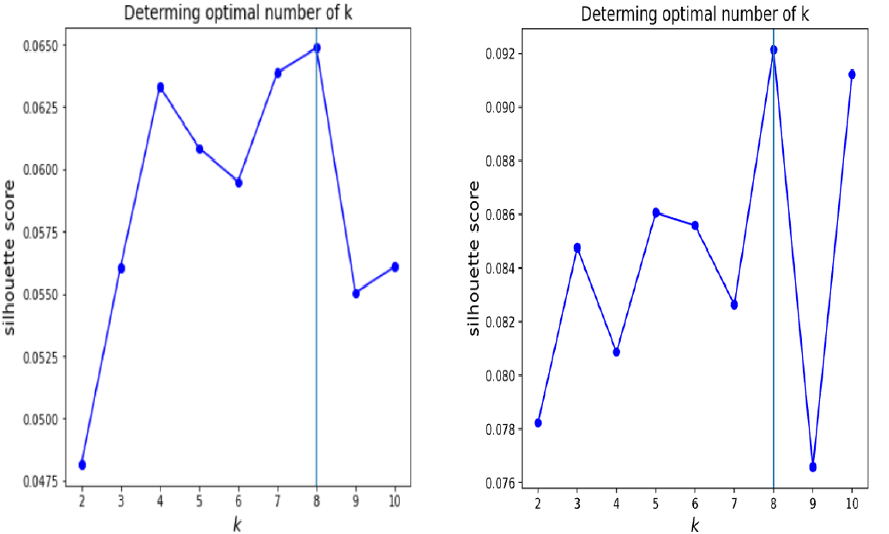
Figure 11. The choice of number of clusters—Word2VeC on the left side and FastText on the right side.